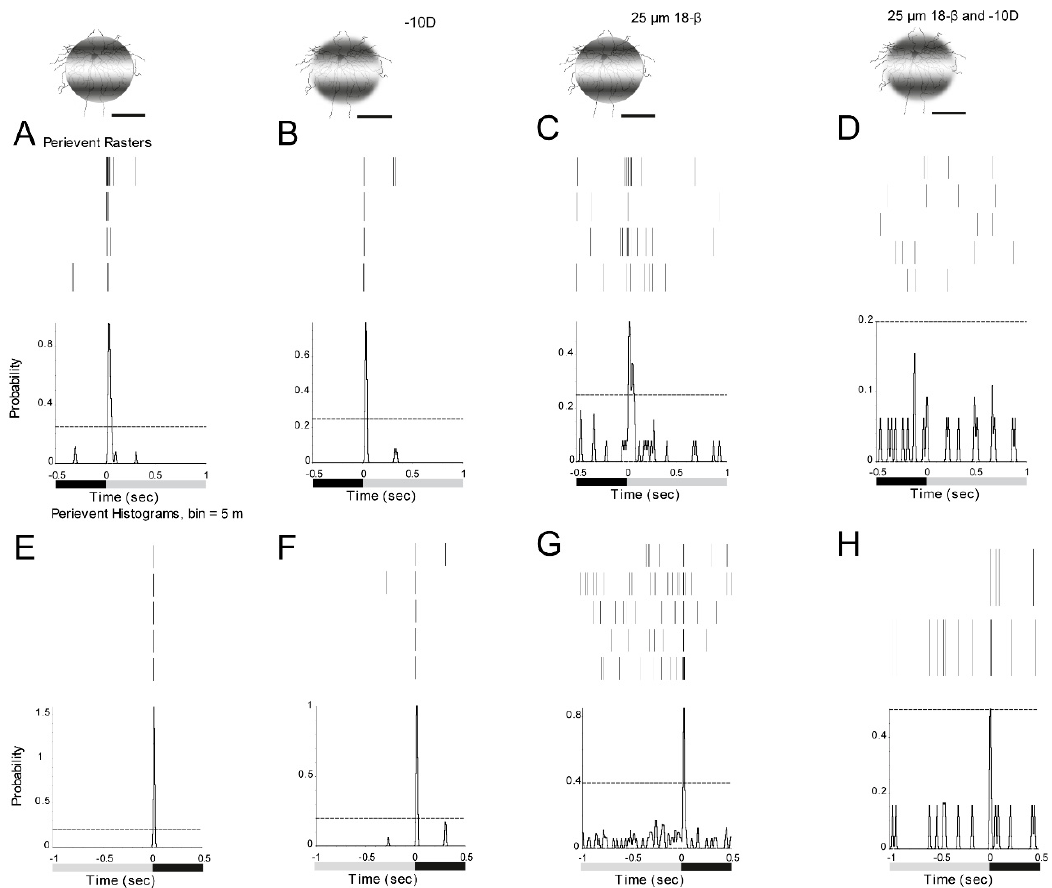
Figure 7. ON and OFF RGCs responses to defocused images can be affected by gap junctions. The ON RGC response can be solely affected by amacrine cells. A : ON α -RGC responses to 1 s 0.002 cycles/degree light stimuli (I = 5.09 × 10 4 Rh*/rod/sec). B : The ON α -RGC response to − 10D defocused image. The peristimulus time histogram of the ON α -RGC showed that the probability of spikes decreased from 0.87 to 0.79. After gap junction antagonist, 25 µM 18-beta-glycyrrhetinic acid (18- β ) application, the probability of spikes decreased from 0.87 to 0.52 ( C ). The probability of spikes decreased from 0.79 to 0 with a − 10D defocused image ( D ). E : OFF α -RGC response to 1 s 0.002 cycles / degree light stimuli (I = 5.09 × 10 4 Rh* / rod / sec). F : The OFF α -RGC response to a -10D defocused image. The peristimulus time histogram of the OFF α -RGC showed that the probability of spikes decreased from 1.58 to 1.01. After gap junction antagonist, 25 µ M 18-beta-glycyrrhetinic acid (18- β ) application. The probability of spikes decreased from 1.58 to 0.85 ( G ). The probability of spikes decreased from 1.03 to 0.51 with -10D defocused image ( H ). However, the 95% confidence limit increased to around 0.5. Scale bar: 75 µ